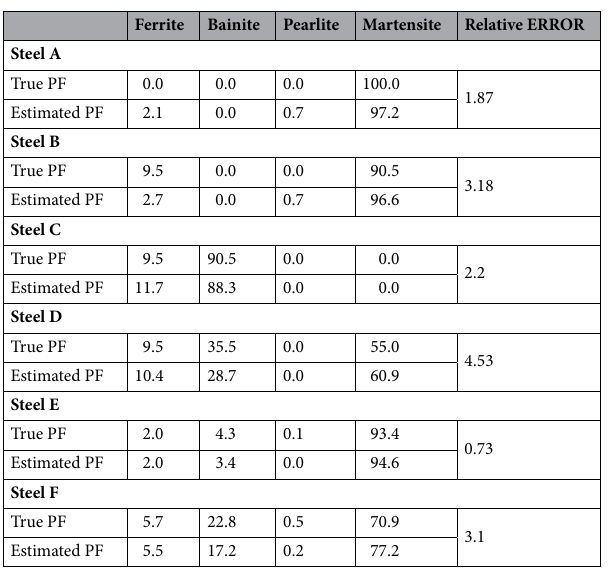
Table 5. True and estimated phase fraction of each type of steel (all units are in percentage).